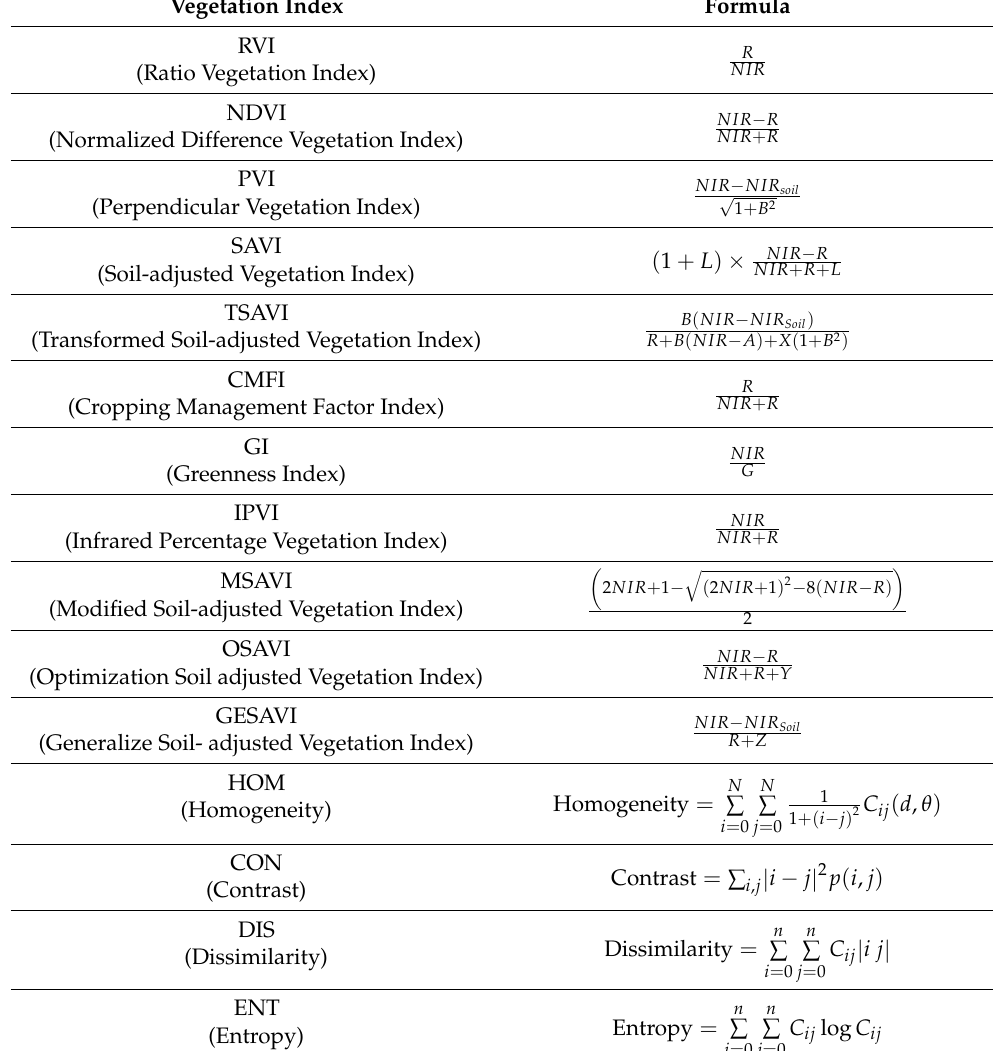
Table 2. Ancillary Information.